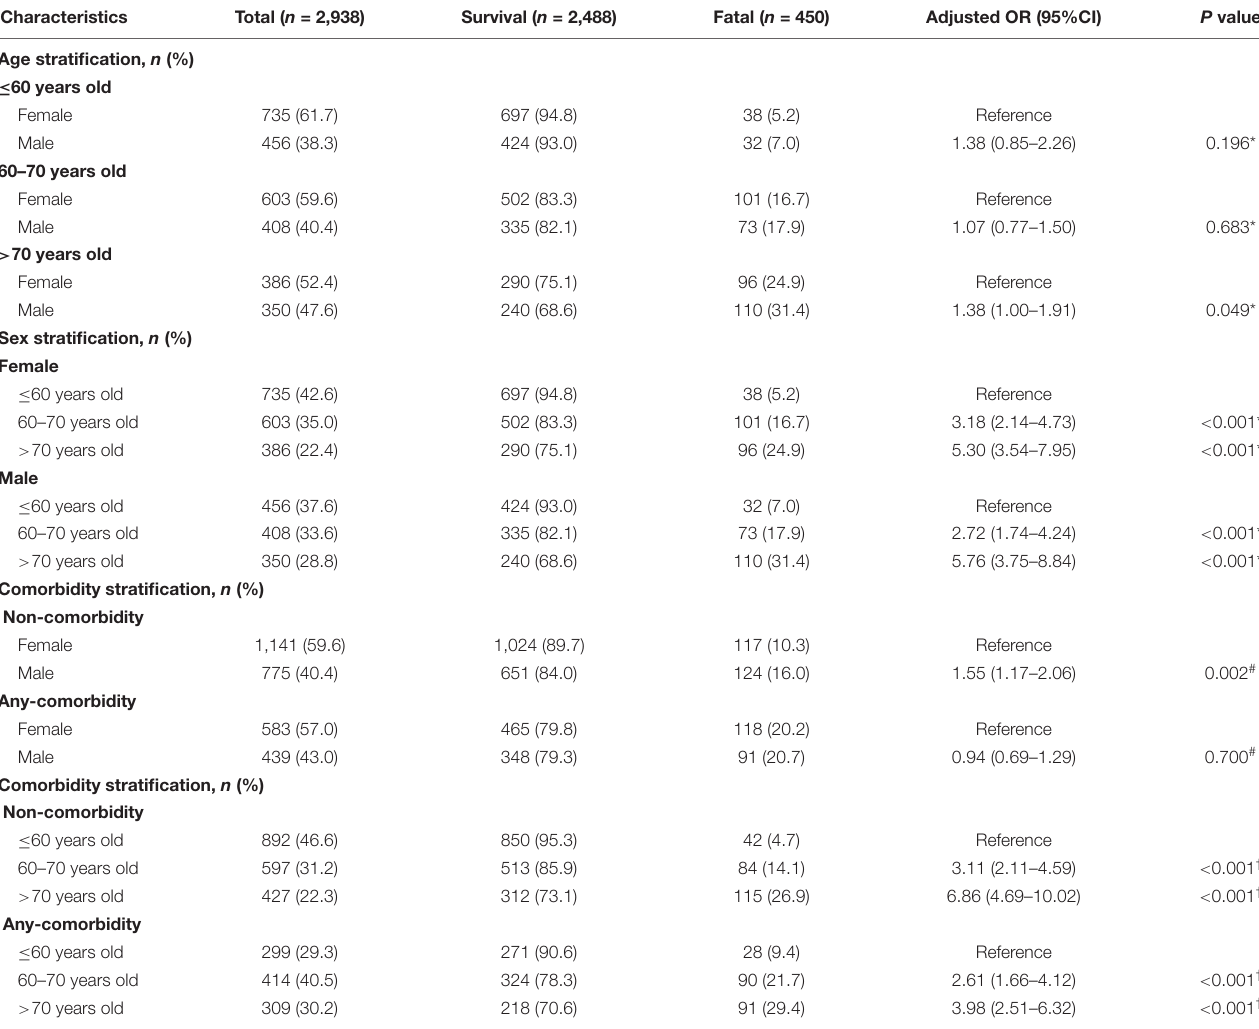
TABLE 2 | The risk of CFR based on age, sex and comorbidity stratifications in SFTS patients.